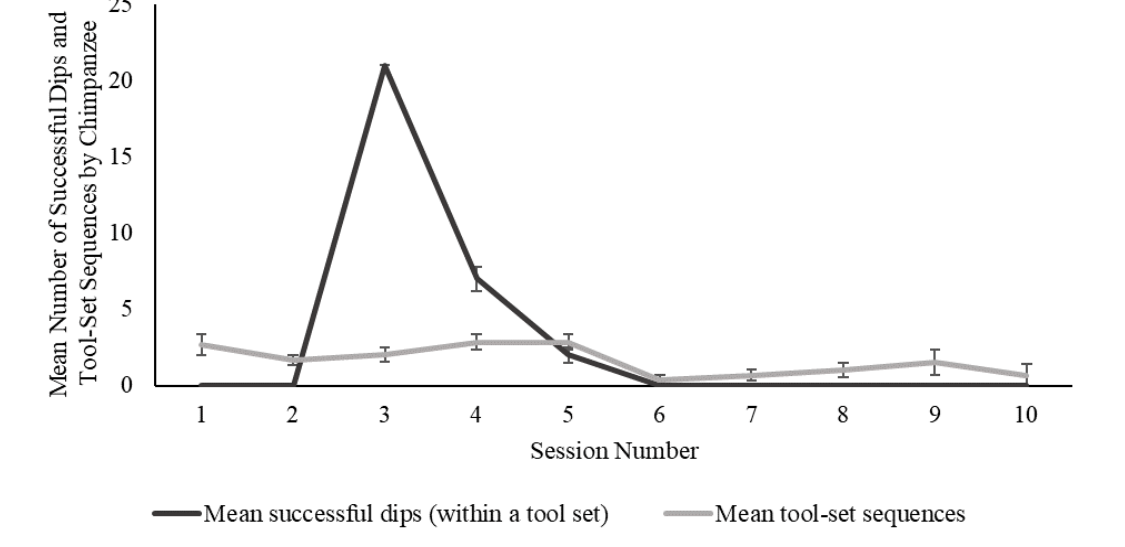
Mean Number of Successful Dips That Occurred Within a Tool-Set Sequence per Chimpanzee per Session and